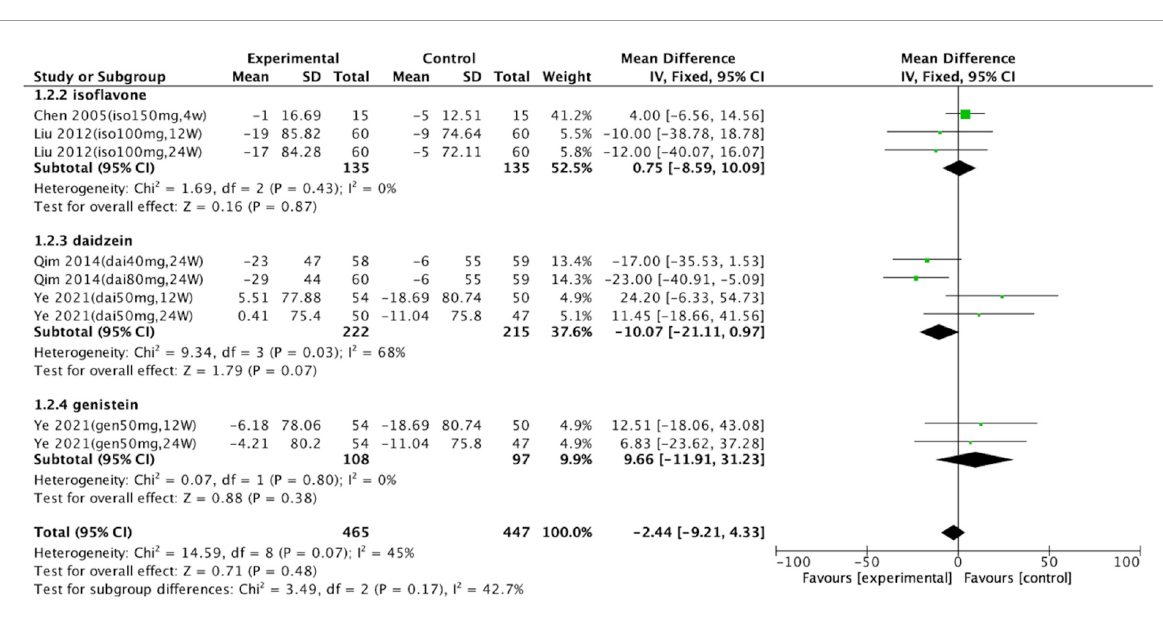
FIGURE3 Forest plot of mean change in uric acid concentration after intervention with soy isoflavones. Subgroup analyses evaluated the effects of daidzein, genistein, and unspecified soy isoflavones (SD, standard deviation; CI, confidence interval; IV, inverse variance; µ